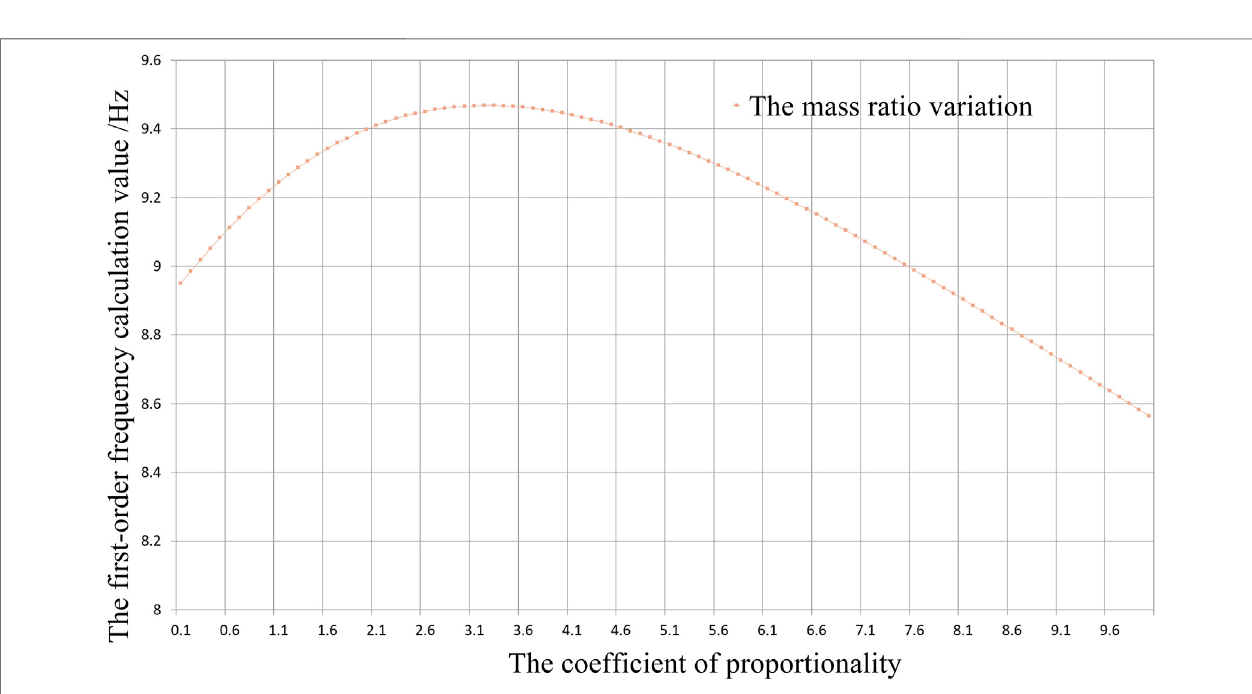
Frontiers in Mechanical Engineering |